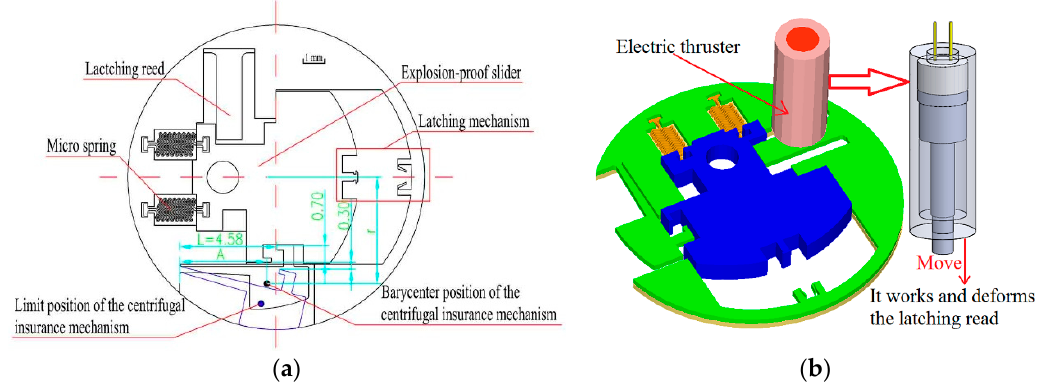
Figure 2. The design scheme of the micro safety and arming (S & A) module. ( a ) The 2D model of the micro S & A module; ( b ) The 3D model of the micro S & A module.